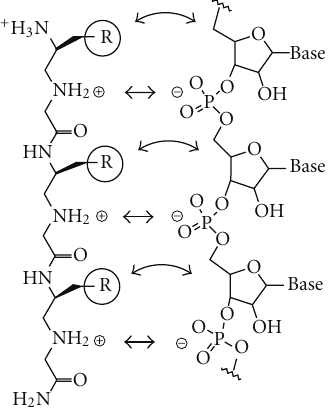
Figure 1: Structural comparison between PAA and RNA showing potential salt-bridges between ammonium groups in the PAA and the phosphodiester backbone of the RNA (straight double- headed arrows) and potential hydrophobic or hydrogen-bonding interactions between the sidechains of the PAA (R) and the RNA (curved double-headed